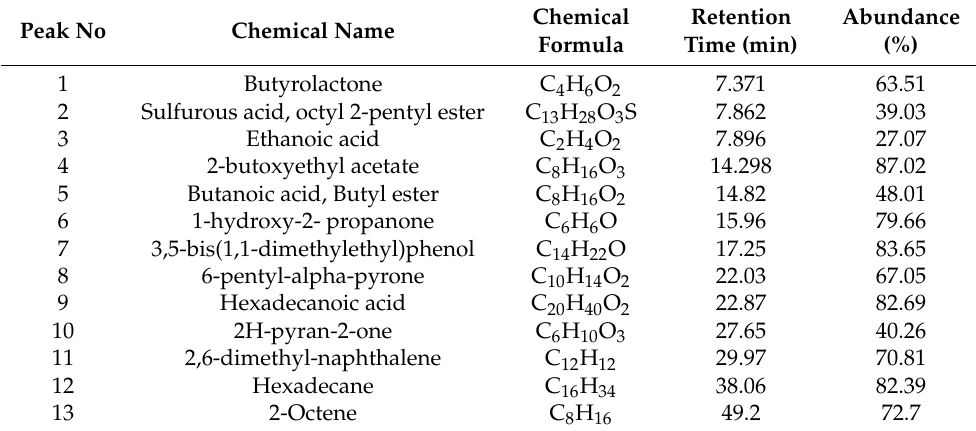
Table 1. GC-MS analysis of the ethyl acetate extract of the volatile compounds produced by T. hamatum